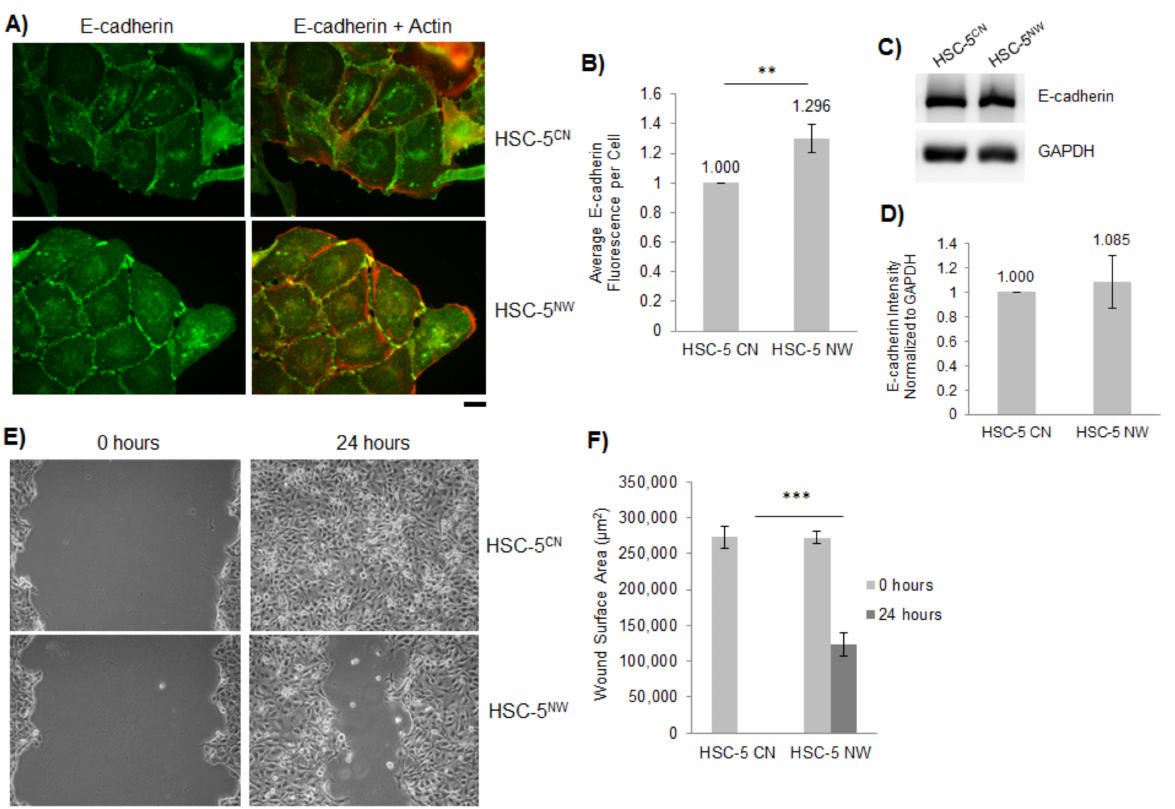
Figure 3. HSC-5 NW cells have increased E-cadherin localization and reduced cell migration. ( A ) Representative immunofluorescence images of HSC-5 CN and HSC-5 NW cells stained for E- cadherin (green). Actin was stained with Alexa Fluor 568 phalloidin (orange–red). Scale bar represents 20 µ m, n = 3. ( B ) Quantification of E-cadherin fluorescence from 20 randomly chosen cells per ex- periment based on the number of interacting cell–cell junctions and normalized to HSC-5 CN cells. ( C ) Representative Western blots of E-cadherin and GAPDH in HSC-5 CN and HSC-5 NW cells; n = 3. ( D ) Densitometric quantification of the E-cadherin/GAPDH ratio in HSC-5 CN and HSC-5 NW cells normalized to HSC-5 CN cells. Values are the mean ± SD, n = 3, p > 0.05. ( E ) Representative images of in vitro wounds of HSC-5 CN and HSC-5 NW cells at 0 and 24 h. Scale bar represents 50 µ m, n = 3. ( F ) Quantification of wound areas performed in ( E ) at respective time-points using ImageJ. All values are the mean ± SD, n = 3, ** p <0.01, *** p <